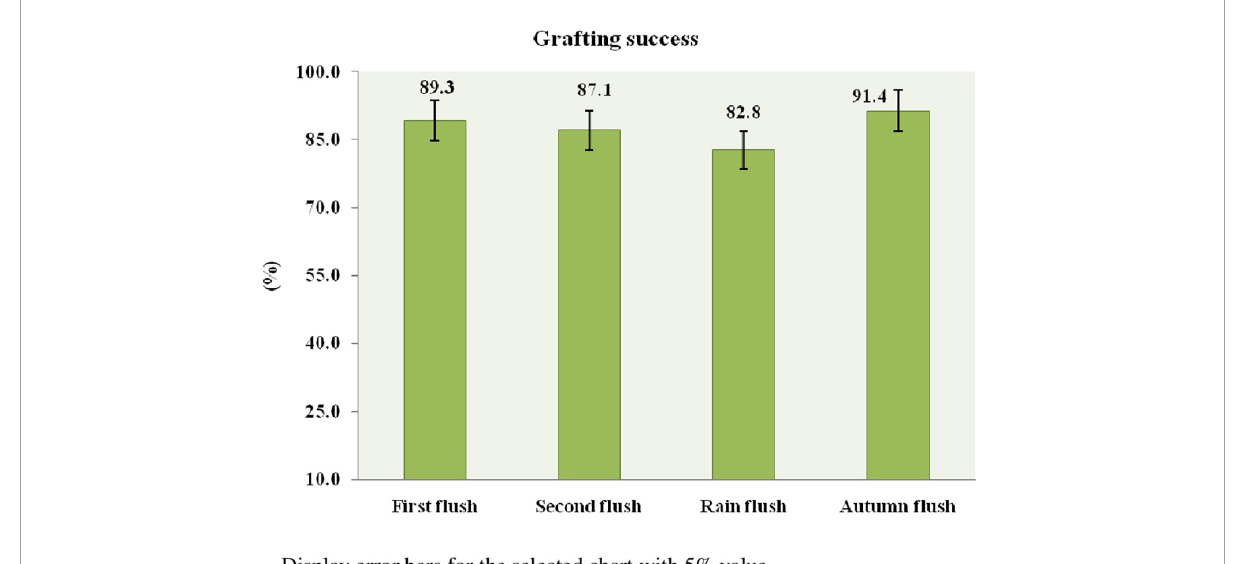
FIGURE5 Effect of flushing on the success of